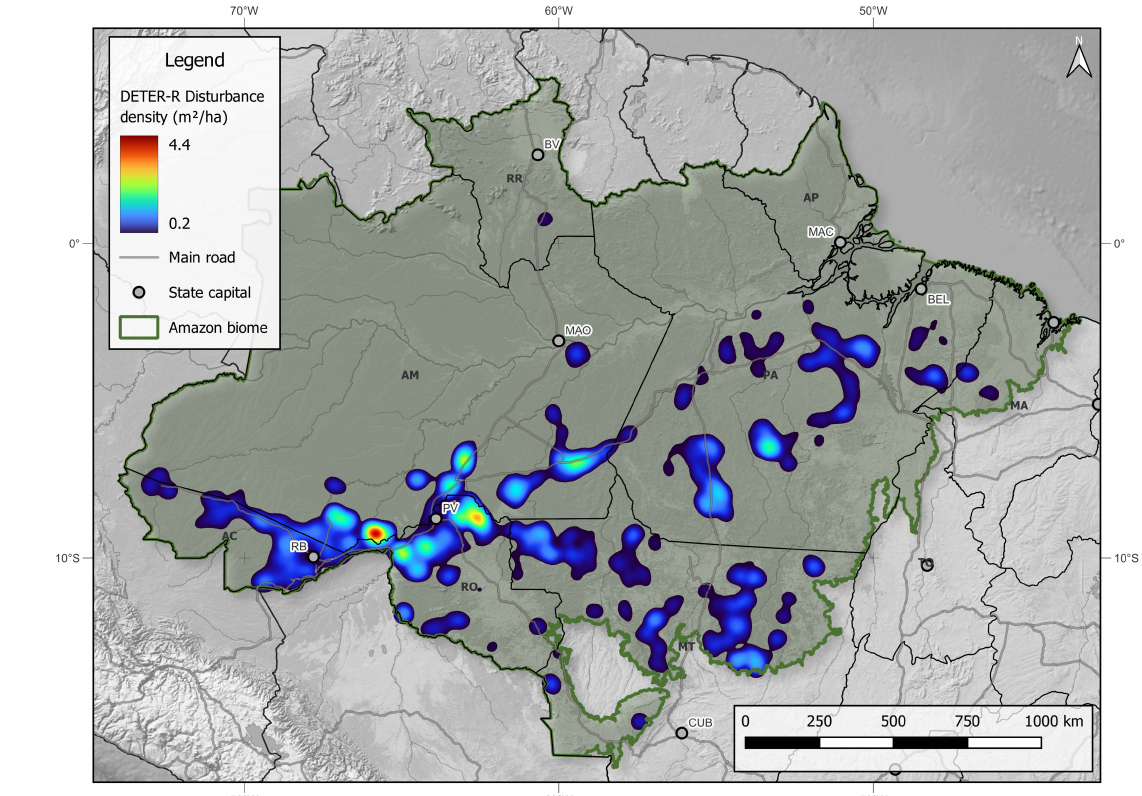
Figure 9. Heatmap of the forest disturbance warnings issued by the DETER-R system on its first year of operation. Disturbance density refers to the area in m² disturbed per hectare, integrated along a circular kernel of 50 km. For clarity purposes, areas with a disturbance density lower than 0.2 m 2 /ha were masked out.